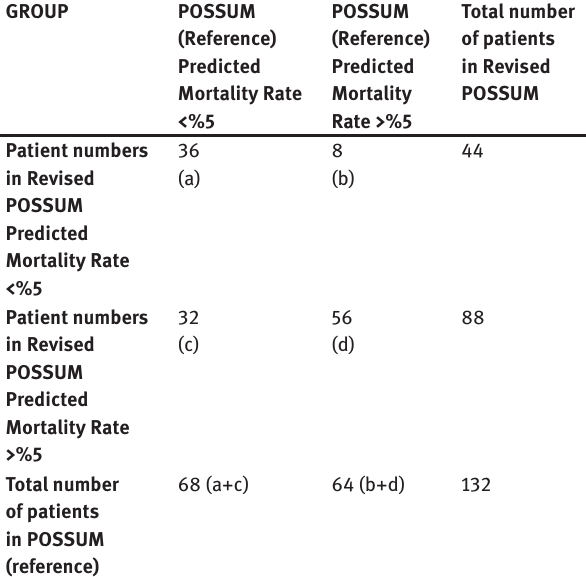
Table 4: Ultimate regression analyses with “backward elimination” of twenty-six parameters revealed that post-operative neopterin, IL-6 and albumin were significantly dependent on the predicted mortality rate (p=0.001, p=0004 and p=0.0001, respectively). In revised POSSUM evaluation, 24 of 68 patients scoring as Group 1 were transferred to Group